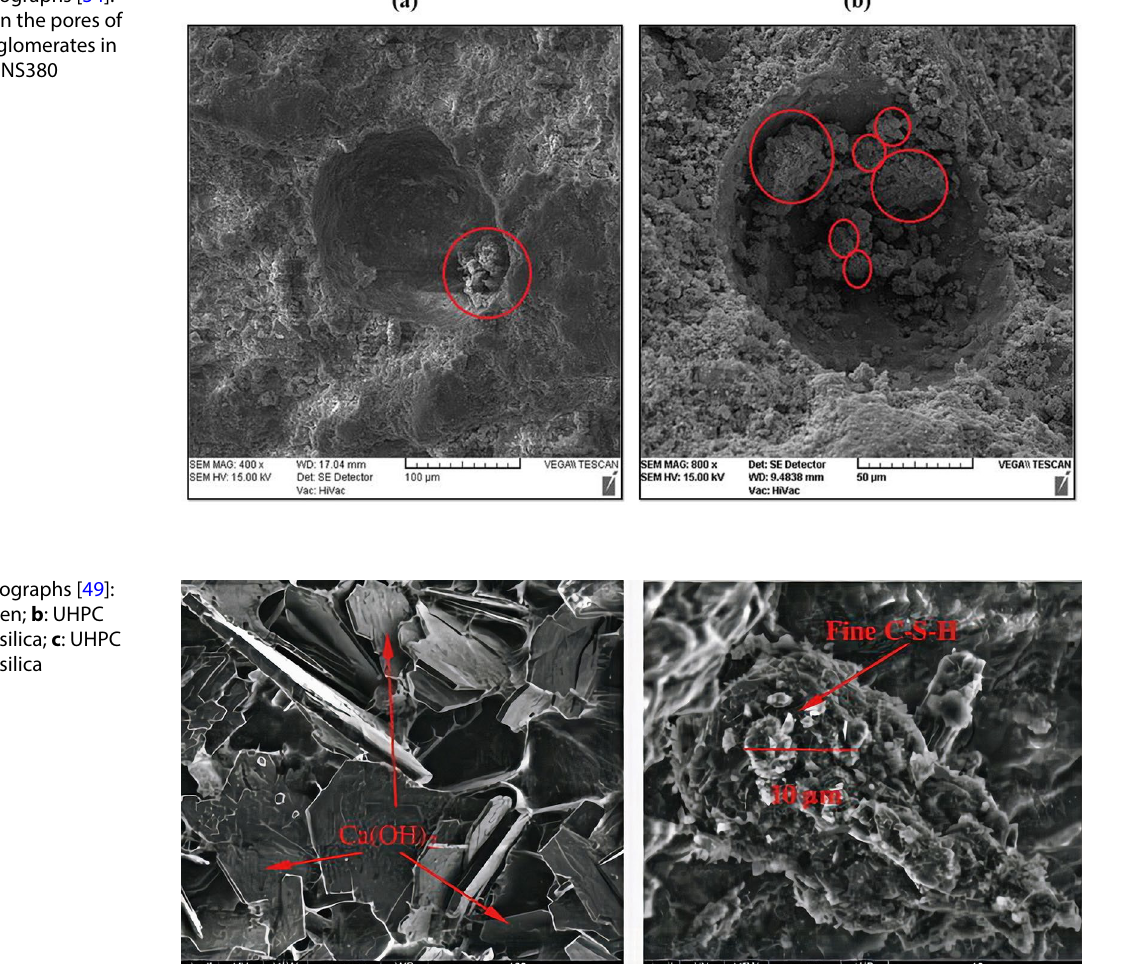
Fig. 12 SEM micrographs [34]: a : agglomerates in the pores of HPC NS200; b agglomerates in the pores of HPC NS380